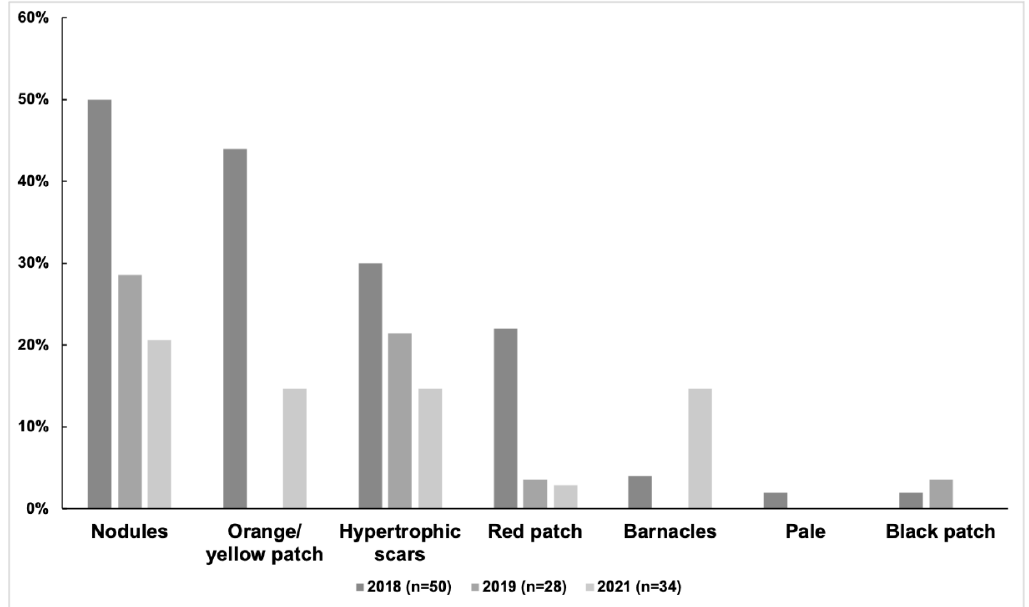
Figure 5. The prevalence of different skin lesion categories in each year (n = 50, 28, and 34). Table 4. Prevalence of skin lesions in 2018, 2019, and 2021.